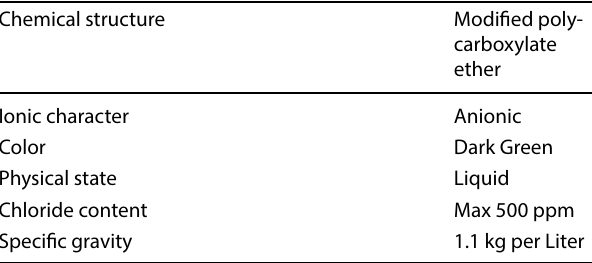
Table 5 Properties of the superplasticizer used in this study Chemical structure